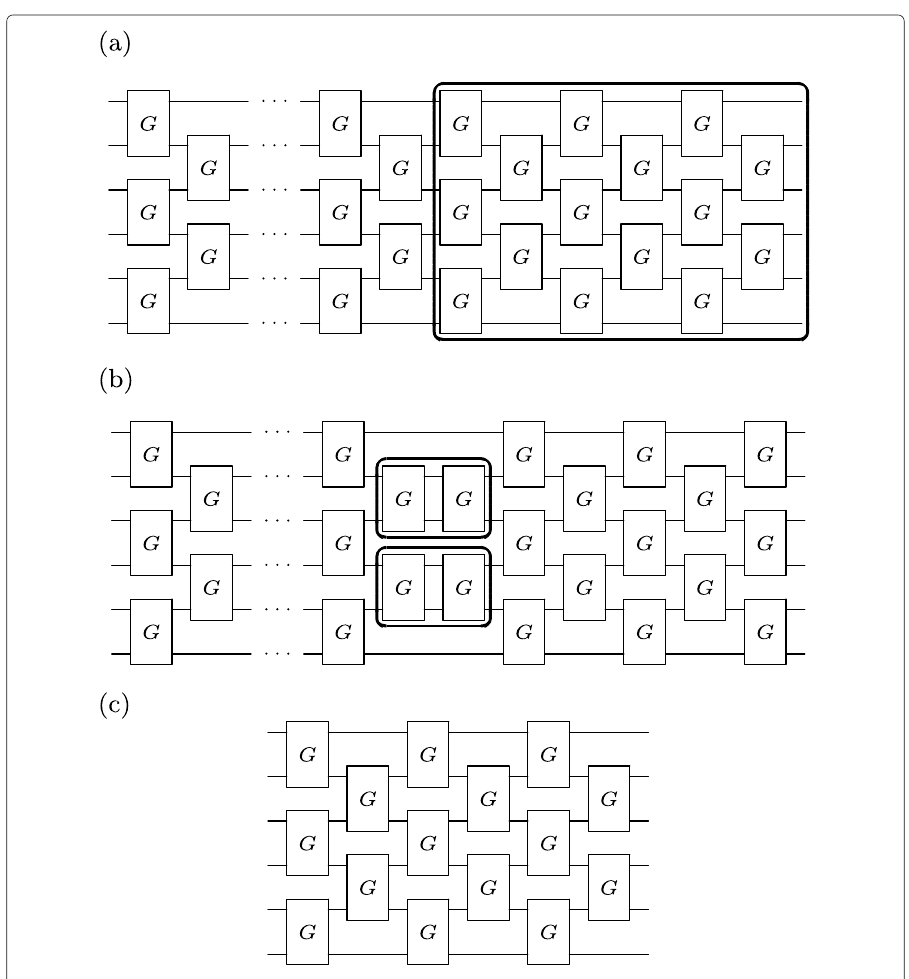
Fig. 2 Downfolding a 6-qubit circuit for n time-steps down to a constant-depth circuit. a The 6-qubit circuit for evolving the system by n time-steps with the time-evolution operator U ( n (cid:3) t ) . A box highlights the last six columns of matchgates to which the matchgate mirroring identity will be applied. b The 6-qubit circuit after application of the H CD matchgate mirroring identity. Pairs of adjacent matchgates on the same